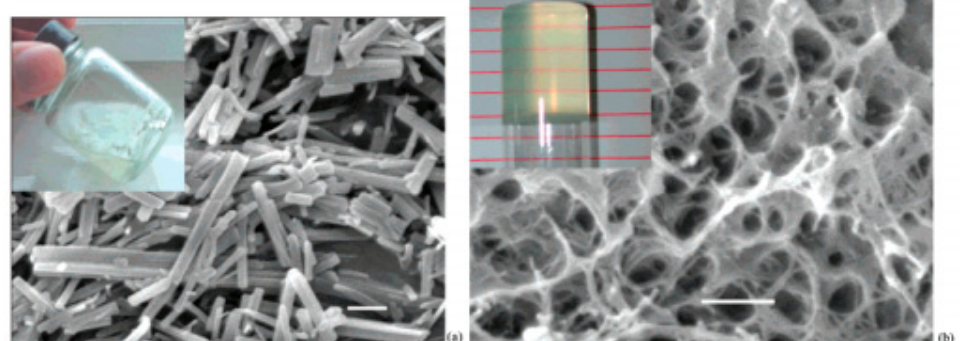
Figure 8. Micrograph of a low molecular gel. Reprinted with permission from [93]. (a) Separate fibers occurring in the 10 wt % L-DHL/DIOP system. It shows L-DHL needles short and thick fibers). This system gives rise to an opaque as shown in the picture on the left upper corner. The length of the bar: 1 μ m. (b) Interconnected fiber networks in 10 wt % L-DHL/DIOP system after adding 0.004 wt % EVACP. It shows L-DHL nanocrystal fibers. This system gives rise to a clear and tough gel as shown in the picture on the right upper corner. The length of the bar: 1 µ m. The acronyms L-DHL / DIOP stand for lanosta-8,24-dien-3 β -ol:24,25-dihydrolanosterol / di-isooctylphthalate; EVACP stands for ethylene / vinyl acetate copolymer. Copyright 2002 American Chemical Society.